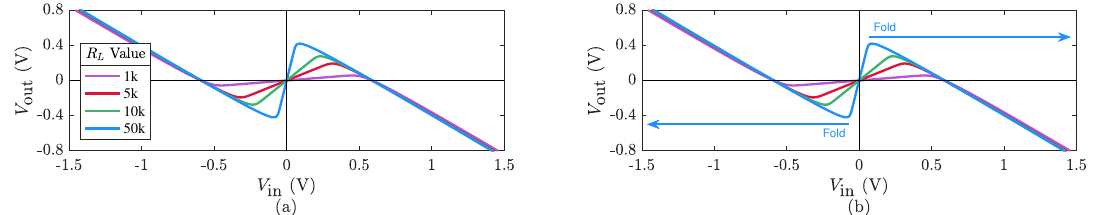
Figure 2. Transfer function of the Lockhart wavefolder simulated using: ( a ) SPICE (Simulation Program with Integrated Circuit Emphasis); and ( b ) the proposed virtual analog (VA) model. Different colors indicate different values of R L .